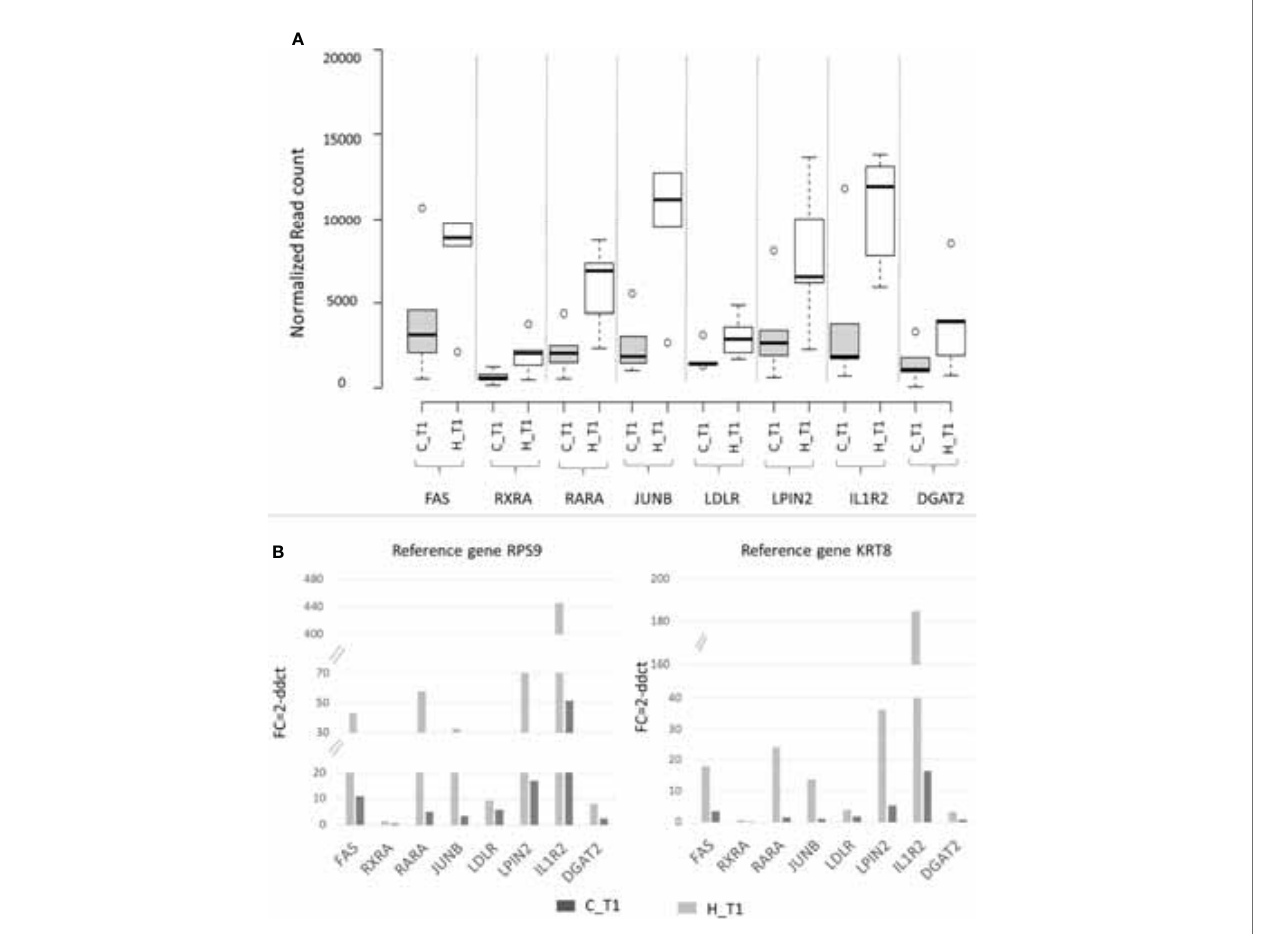
FIGURE 5 | (A) Box plot of RNA expression (normalized read count) and (B) real-time qPCR expression (fold change) for a subset of DEGs ( FAS , RXRA , RARA , JUNB , LDLR , PLIN2 , IL1R2 , and DGAT2 ) in the hemp (H) and control (C) groups at T1. Ribosomal protein S9 ( RPS9 ) and keratin 8 ( KRT8 ) were used as reference